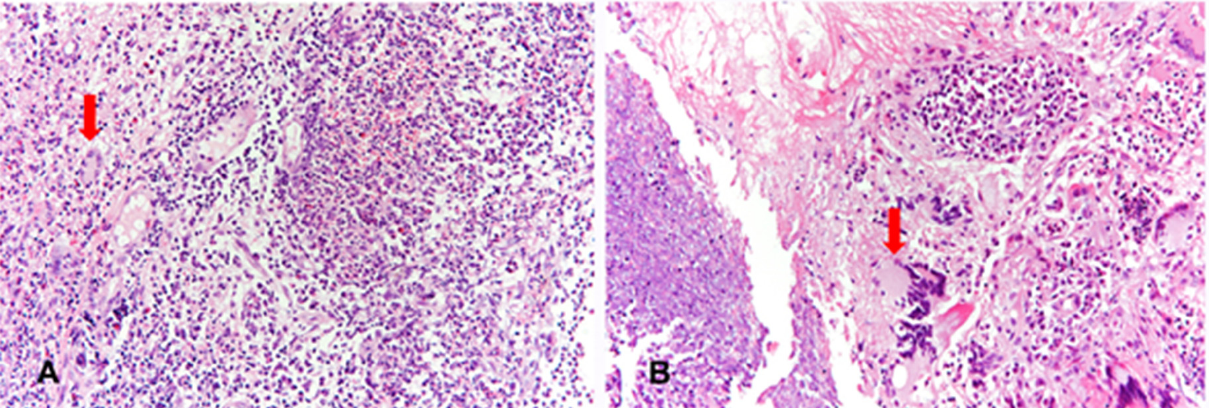
Figure 2. Histopathological findings of nasal mucosa at diagnosis ( A ) and bronchial mucosa at relapse ( B ). Nasal and bronchial mucosa show necrotizing granulomatous inflammation, consisting of basophilic necrosis, epithelioid histiocytes, and multinucleated giant cells (arrows). (hematoxylin and eosin statin, ×200).